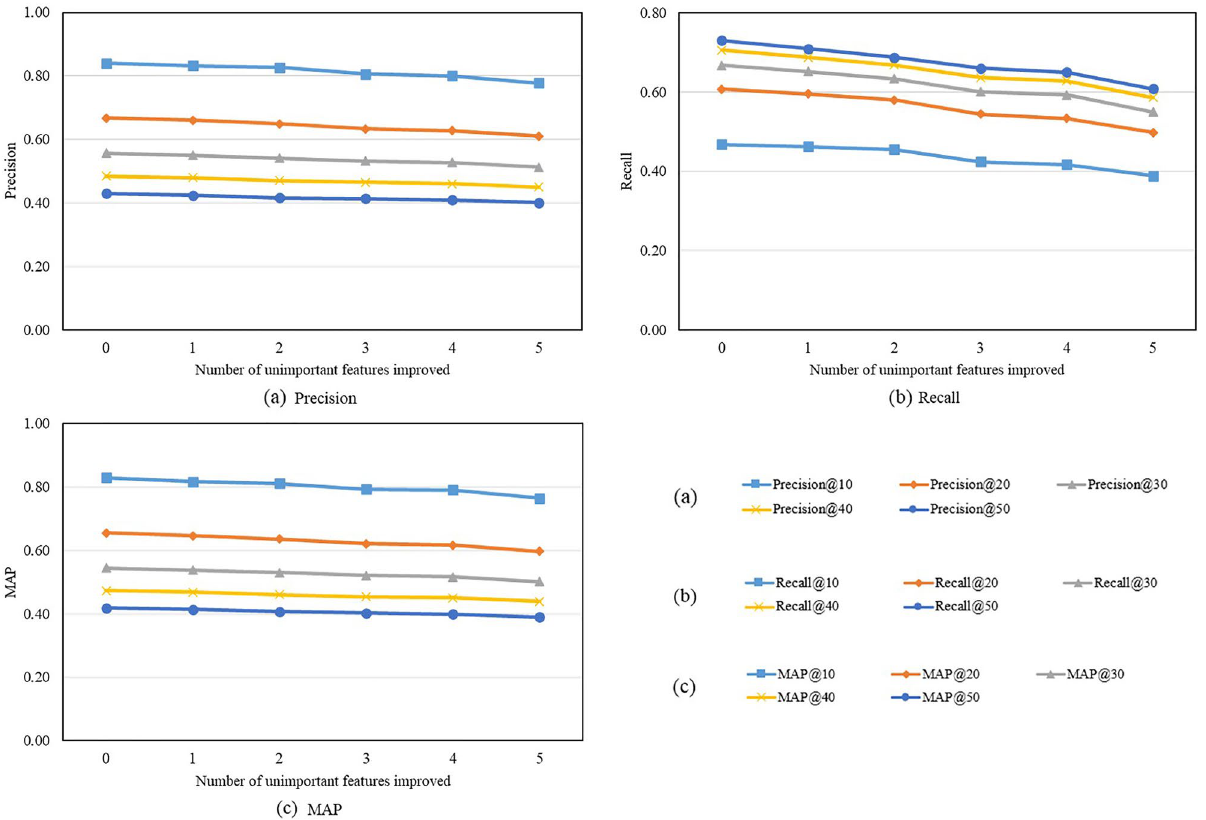
Figure 6. Recommendation performance after removing unimportant